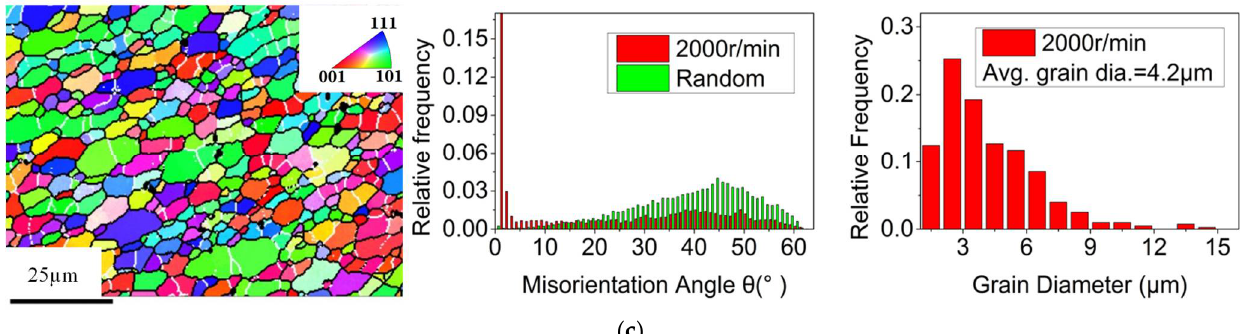
Figure 4. Grain morphology, misorientation angle and grain size of the nugget zone at different plug rotation speeds: ( a ) 1600 rpm, ( b ) 1800 rpm and ( c ) 2000 rpm.